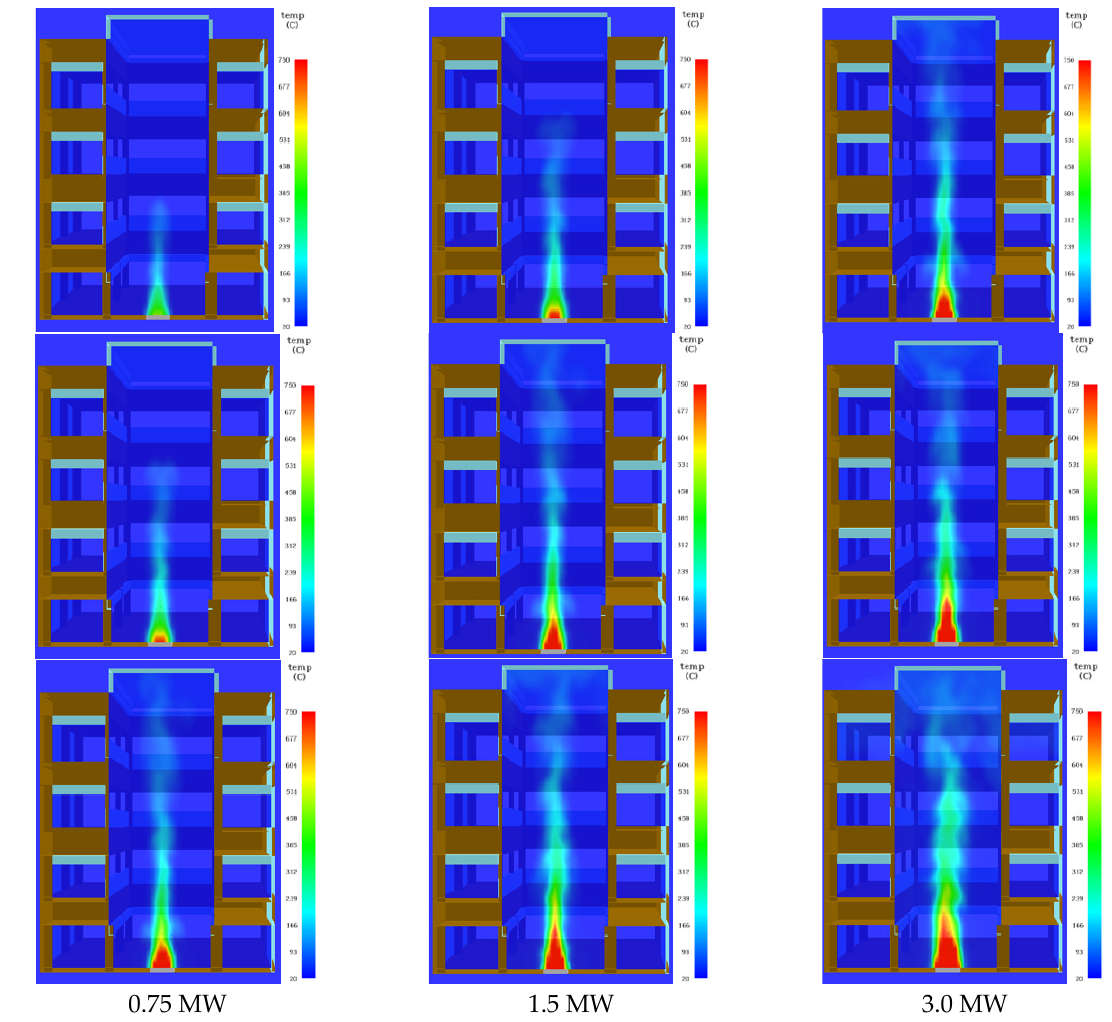
Figure 5. Fire smoke temperature distribution inside the atrium at different heat release rates and